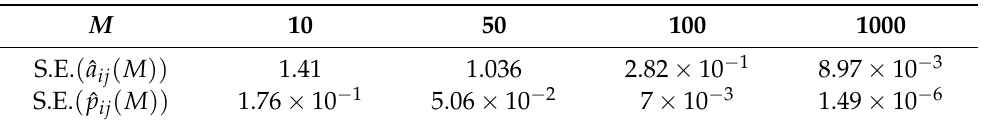
Table 2. Squared errors (S.E.) for the estimators of a ij and p ij in the case of no censoring, for various values of M .